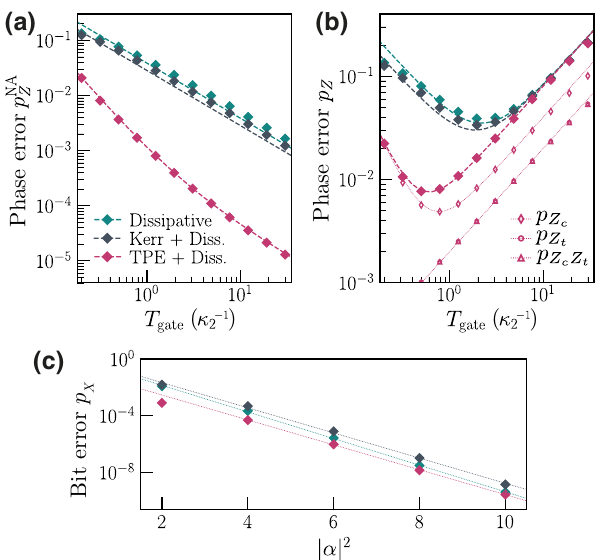
FIG. 11. (a) Nonadiabatic phase errors of a CNOT gate at | α | 2 = 4, with different confinement schemes: two-photon dis- sipation (green), combined Kerr and two-photon dissipation at K /κ 2 = 0.3 (gray), and combined TPE and two-photon dissi- pation at g 2 /κ 2 = 10 (magenta). For this last scheme, the con- finement is turned off on the target cat qubit during the gate. (b) Phase errors of a CNOT gate for the same confinement schemes, with single-photon loss at rate κ 1 = 10 − 3 κ 2 , thermal noise n th = 10 − 2 , and pure dephasing κ φ = 10 − 5 κ 2 on both control and target qubits. Full markers show total phase error, empty markers show the breakdown of phase errors for the combined TPE scheme. Gate times are in units of 1 /κ 2 . (c) Total bit-flip errors of a CNOT gate for the same confinement schemes, with noise rates as in plot (b), and at gate time T gate = 1 /κ 2 . For all plots, a constant gate Hamiltonian drive is used, and markers indicate numerical data. Dashed lines indicate analytical fits, and solid lines indicate numerical fits of exponential